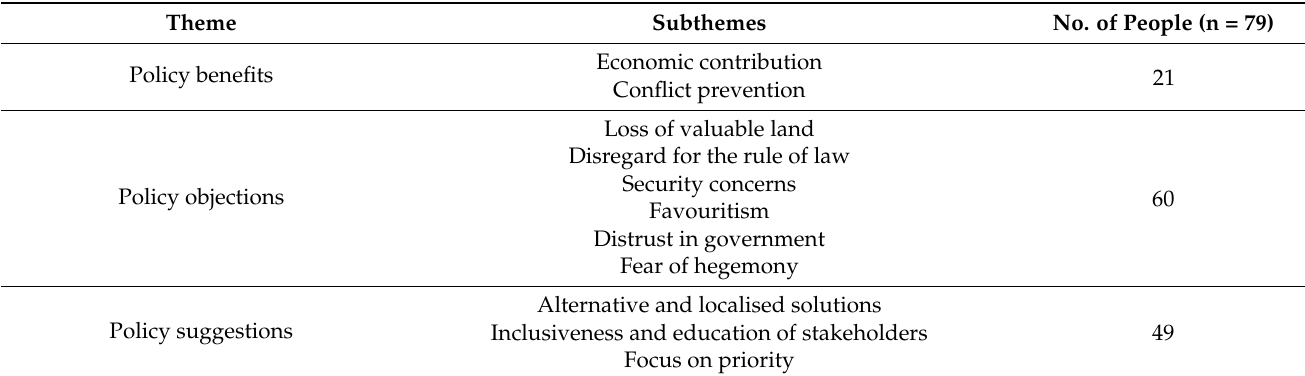
Table 1. Numbers of people and their expressed thematic perceptions.